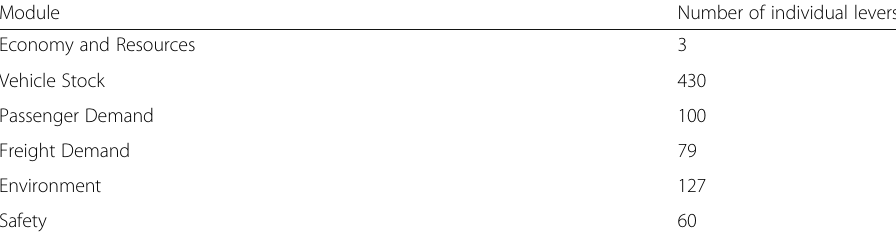
Table 4 Number of policy levers per module for the Customised Policy package interface